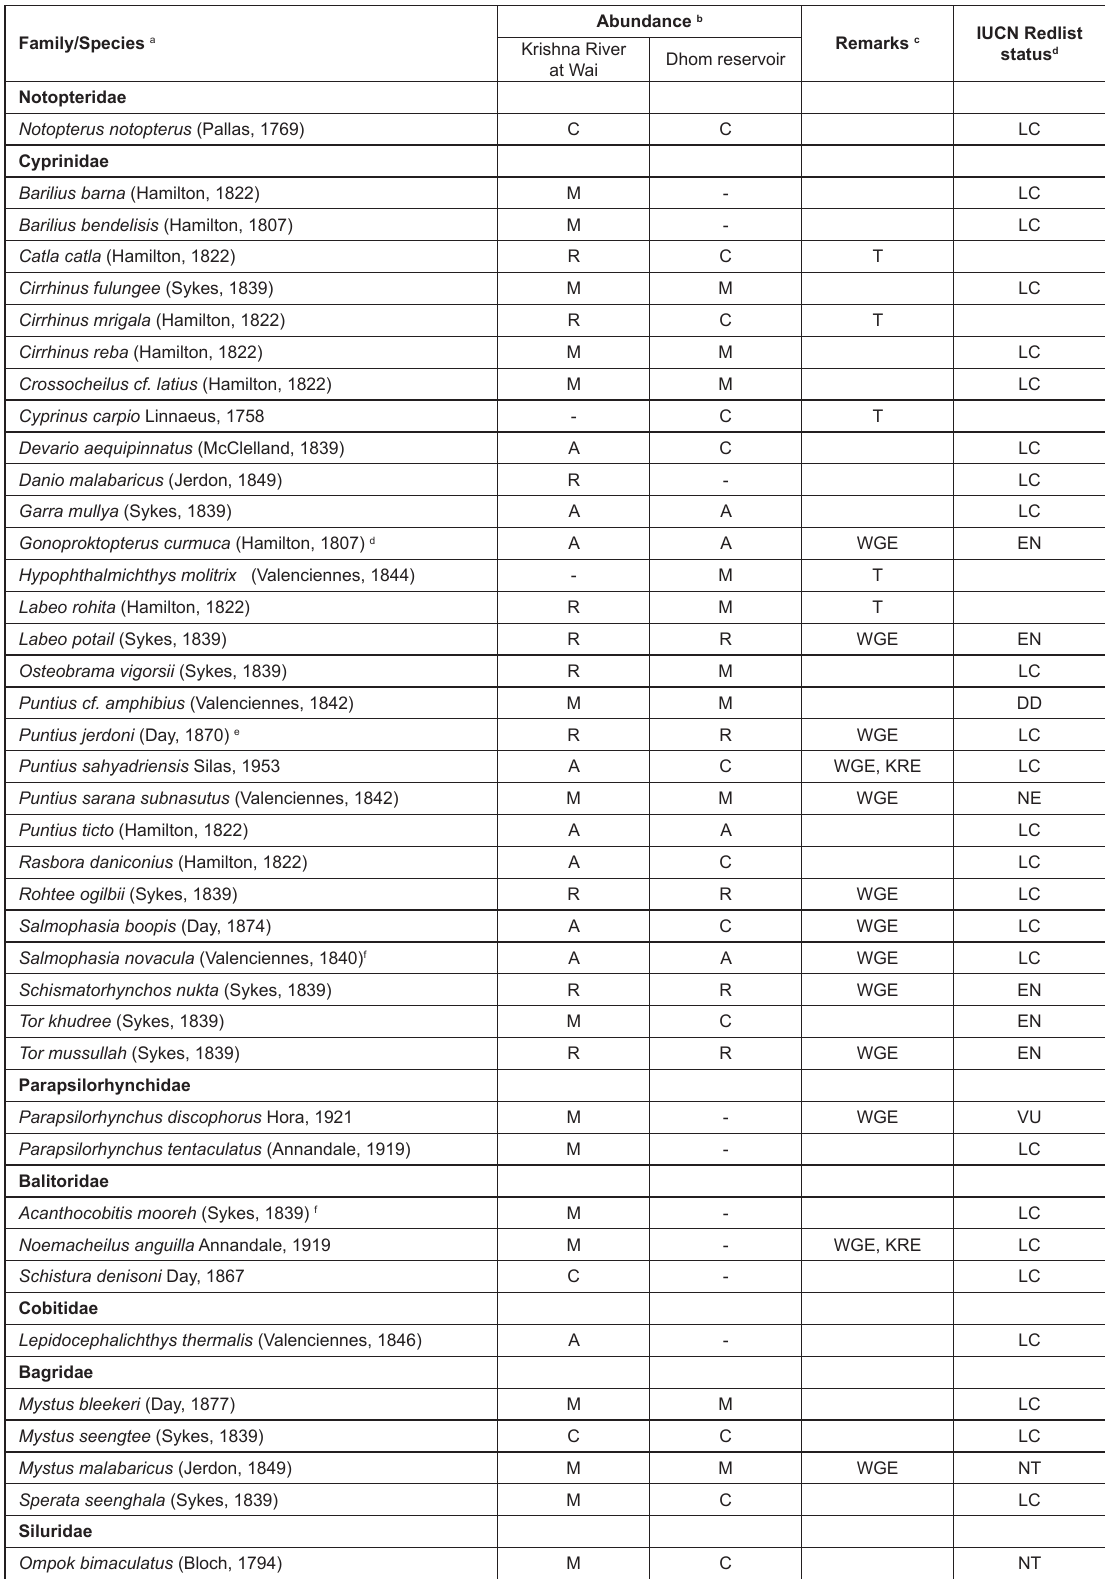
Table 1. List of freshwater fish from Krishna